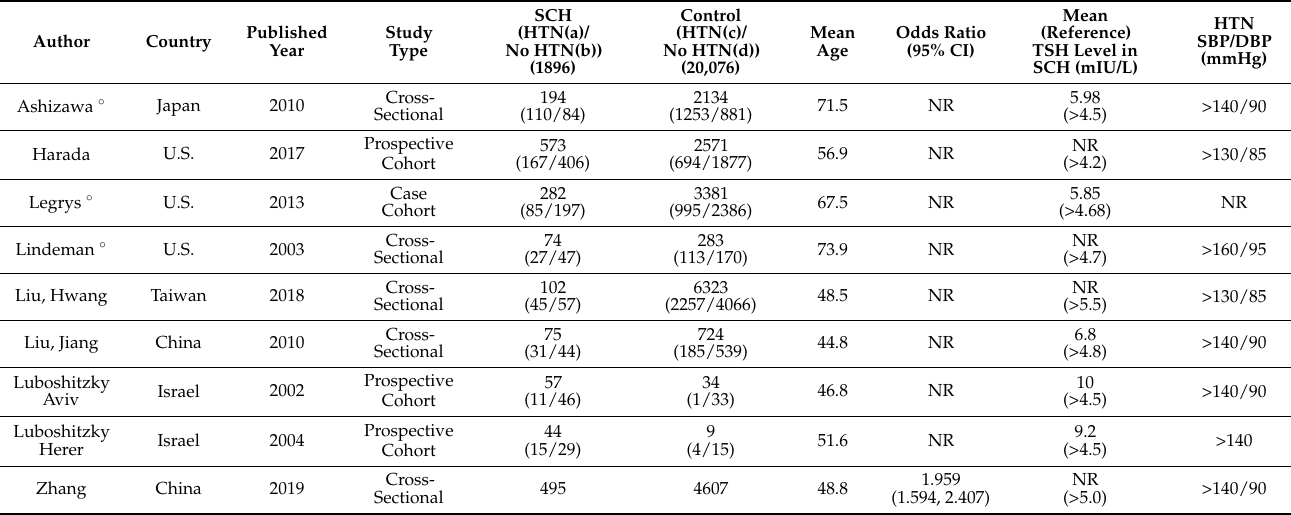
Table 1. Main characteristics of the included studies ( n = 9). Three studies with the superscript “ ◦ ” belong to the older subgroup with mean age ≥